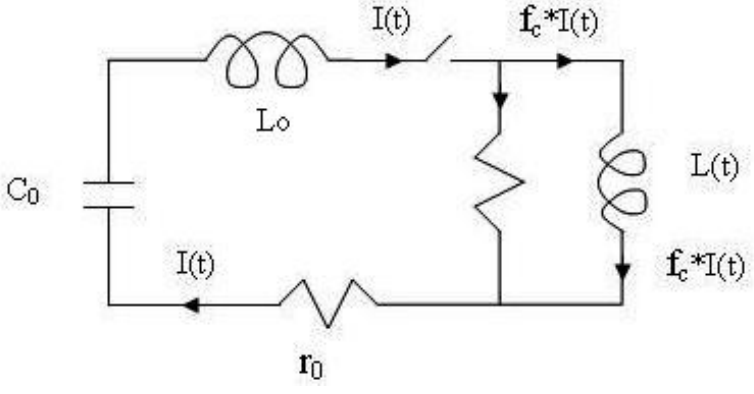
Figure 13. Plasma focus circuit schematic. The capacitor bank with static inductance L and stray resistance r is switched into the plasma focus tube where a fraction f 0 circuit current I(t) effectively drives the plasma creating a time-varying inductance L(t) in the focus